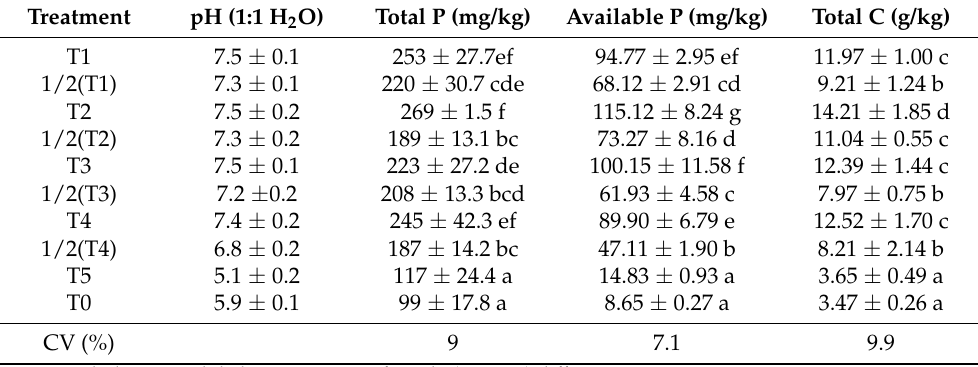
Table 5. Effects of amendments on residual soil